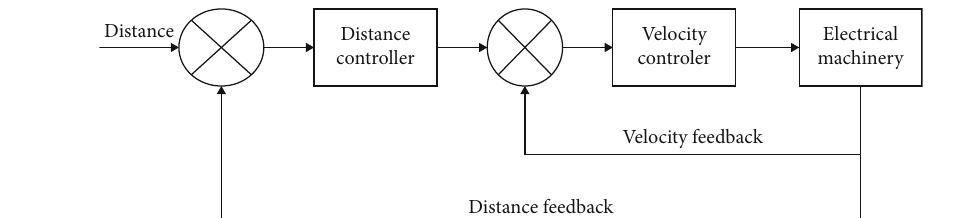
Figure 6: Cascade control structure.